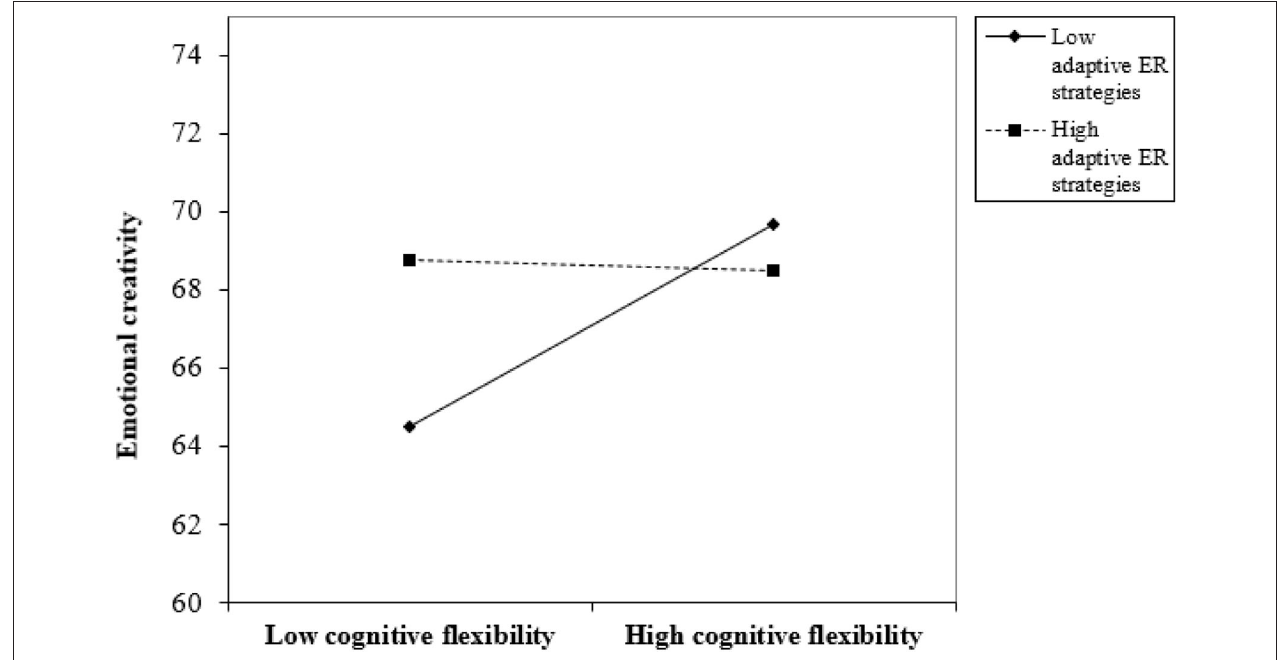
FIGURE 6 | Interaction plot of the moderating effect of adaptive ER strategies on the relationship between cognitive flexibility and